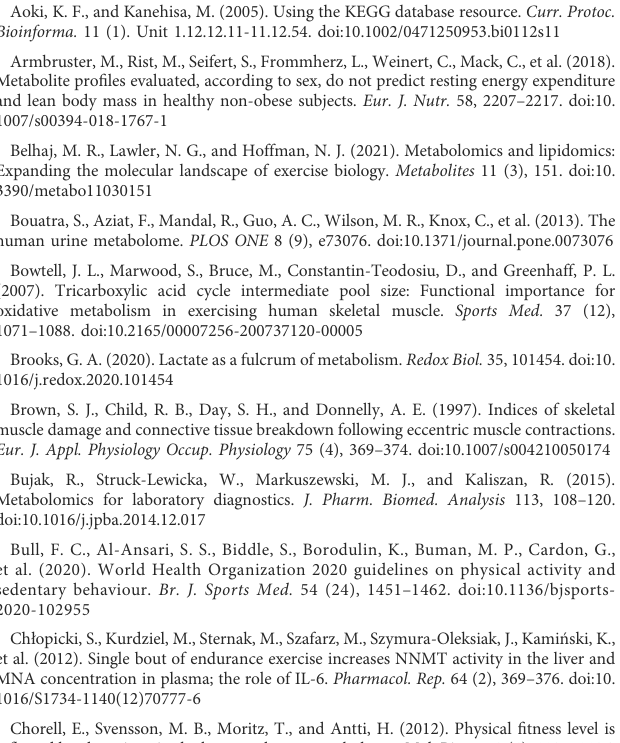
Bar charts showing absolute urinary creatinine excretion (medians and interquartile ranges are displayed) at the three post-exercise sampling time points within the CME and CVE